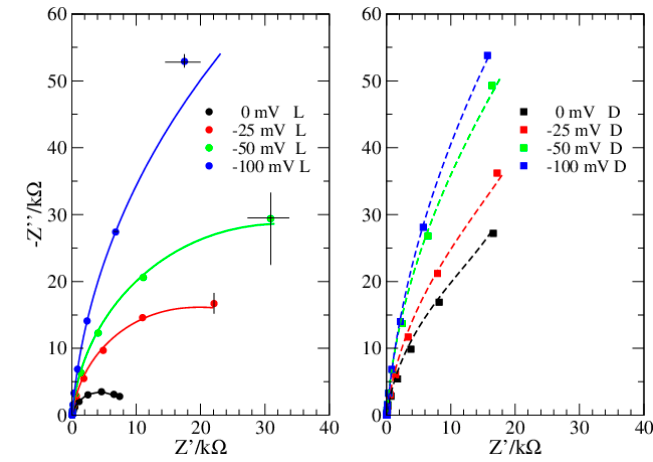
Figure 1. Dataset 1. Data taken in light (circles) and dark (squares). Lines reproduce data from simulations.